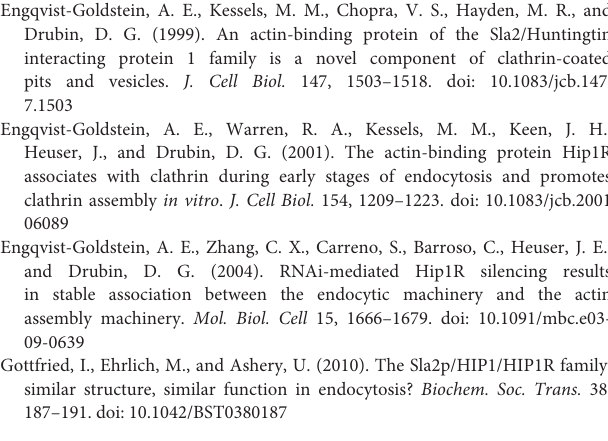
FIGURE S1 | All raw blots show both molecular weights and the blot insets for each main